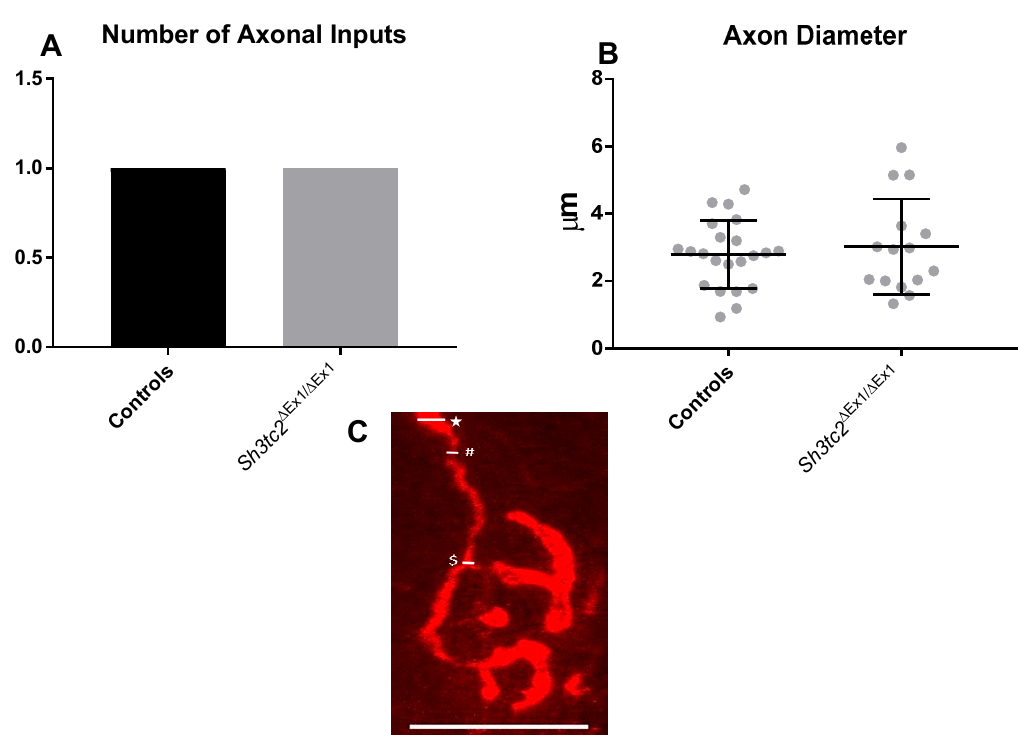
Figure 5. Axonal parameters in Sh3tc2 ∆ Ex1 / ∆ Ex1 ( n = 3) and control ( n = 3) animals: ( A ) Only single axonal inputs were observed for both Sh3tc2 ∆ Ex1 / ∆ Ex1 (NMJs n = 15) and control ( n = 22) animals, therefore no SEM is given; ( B ) There were no differences in the axon diameter (unpaired t -test). ( C ) Axon inputs were identified with neurofilament staining and the diameter determined by measuring the axon at its widest (*) and thinnest (#) points, and where the axon ramifies ($). Graphs are mean ± SEM, scale bar is 25 μ m.